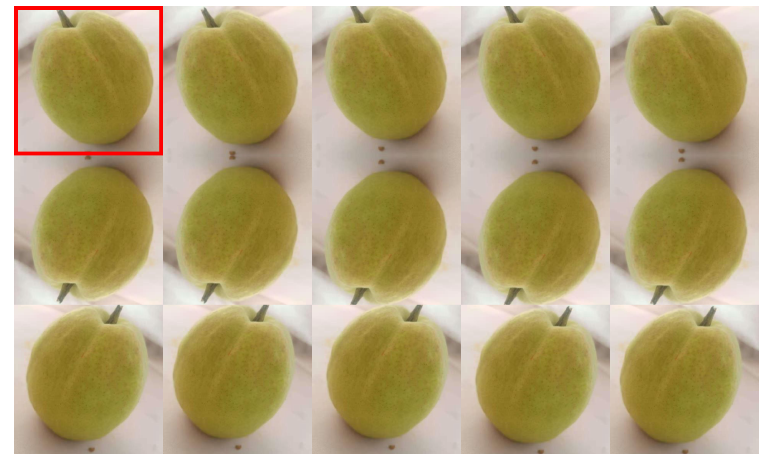
Figure 1. All amplified images corresponding to a single image.